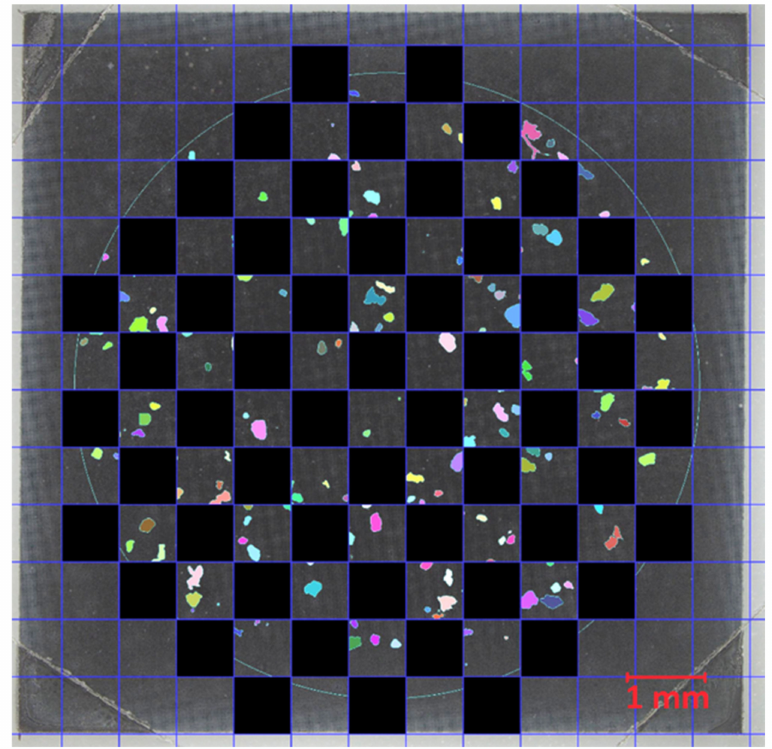
Figure 3. Partially analyzed filter area (exemplary checkerboard